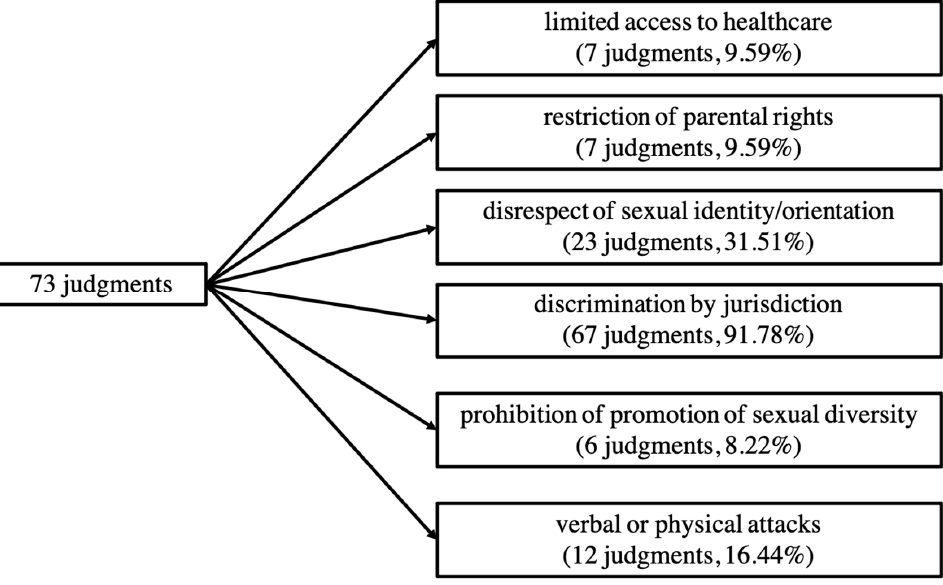
Figure 3. General count and percentages of judgments we found regarding each